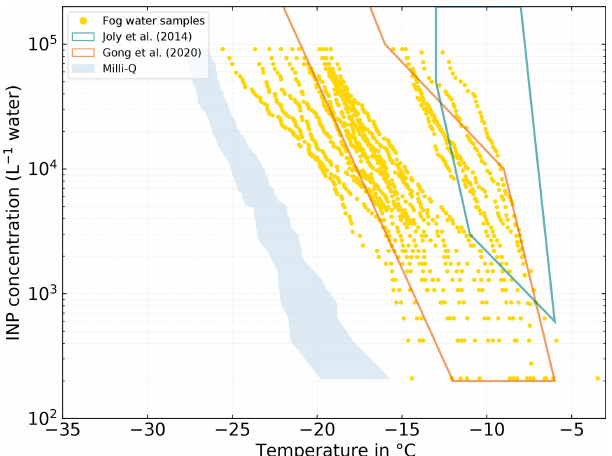
Figure 9. Fog-water-derived N INP in air. N INP was derived from Eqs. (5) and (6) with the median N CCN (SS = 0 . 15%) during the time of each fog sample and an average droplet diameter ( d drop ) of 17µm. The error bars show the range with d drop of 12 and 22µm, respectively. See Sect. 3.3.1 for details on the derivation